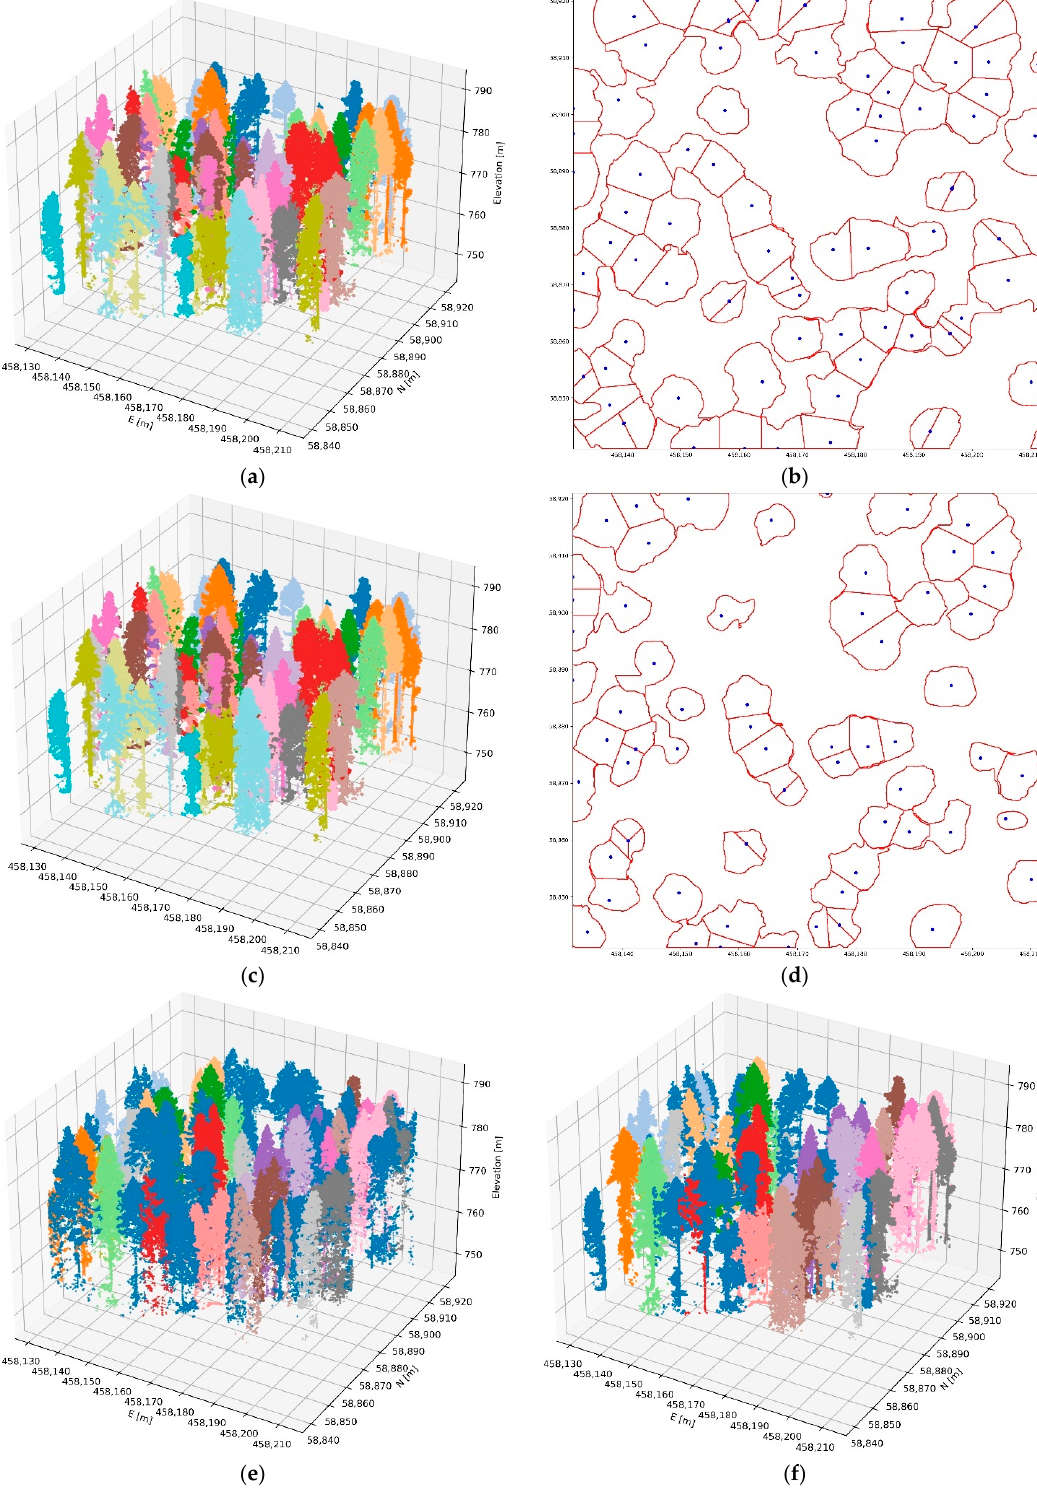
Figure 4. Segmentation and matching outputs. ( a ) Single-tree segmentation of the point cloud acquired in November 2013. ( b ) Crown shape and position of the trees in November 2013. ( c ) Single-tree